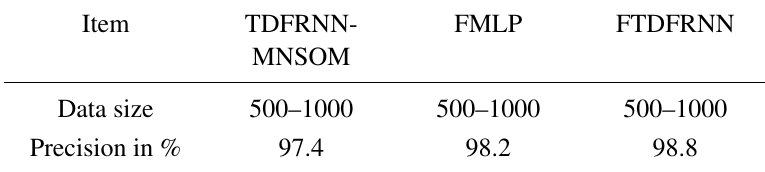
Table 5. Precision of FMLP and FTDFRNN with respect to